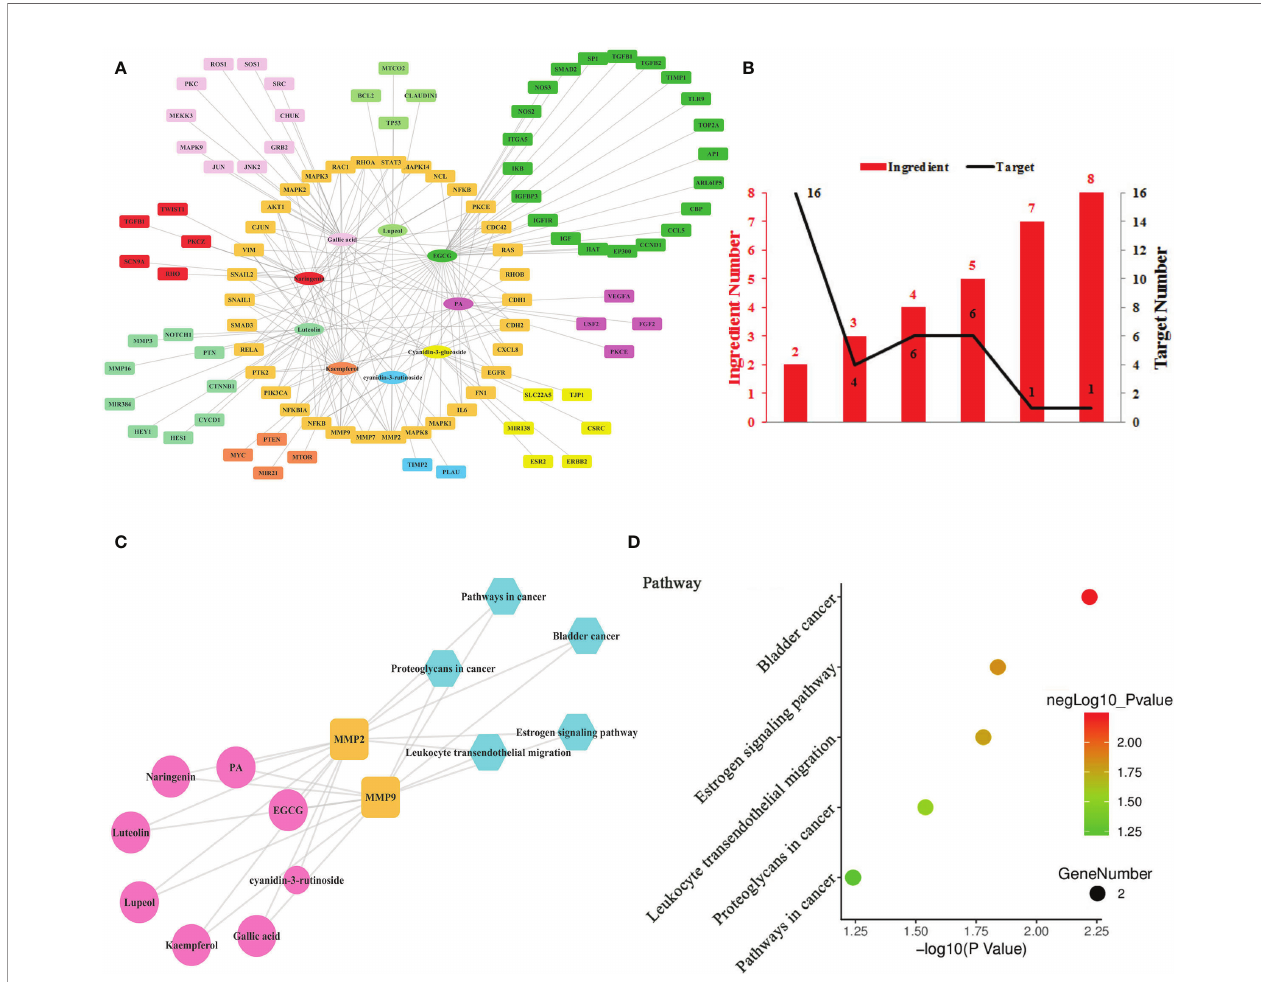
FIGURE 3 | Ingredient-Target Network of Litchi Inhibiting Cancer Metastasis. (A) The ingredient-target network of 9 ingredients (oval) associated with 99 targets (rectangle). (B) The histogram of “ ingredient and corresponding target number ” . (C) The ingredient-top target-signal pathway network. The round rectangle nodes (orange) represent 2 top targets, ellipse nodes (pink) represent 8 ingredients acting on top targets, the size of the nodes is positively related to their degrees in the network, the hexagon nodes (blue) represent signal pathways enriched based on top targets. (D) The top 5 pathways based on KEGG enrichment